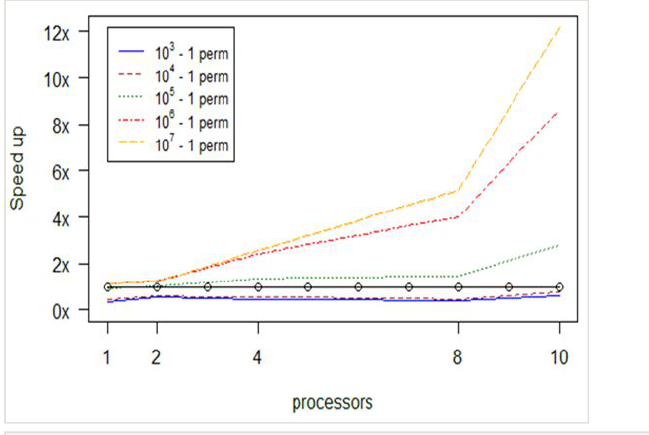
Computational results about optimization in the performance of adonis , depending on permuations and number of processors